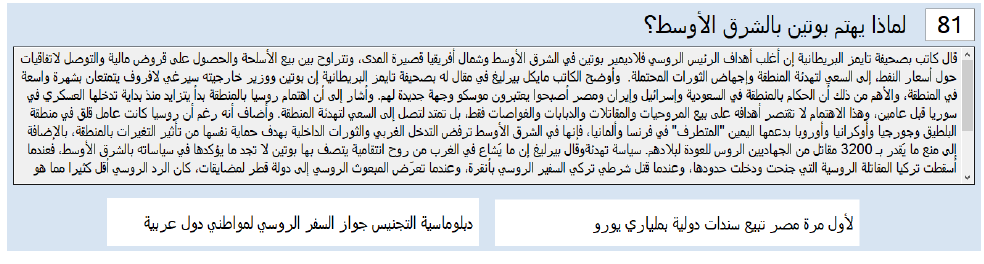
Figure A6. Sample number 4.